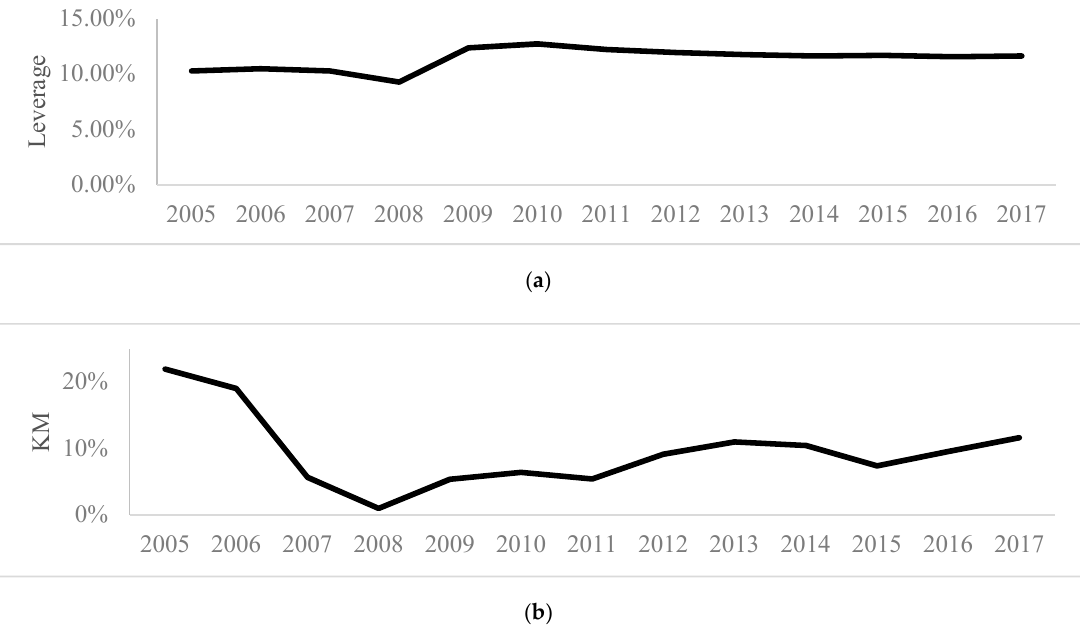
Table 2. Historical figures for the US banking market as a whole.